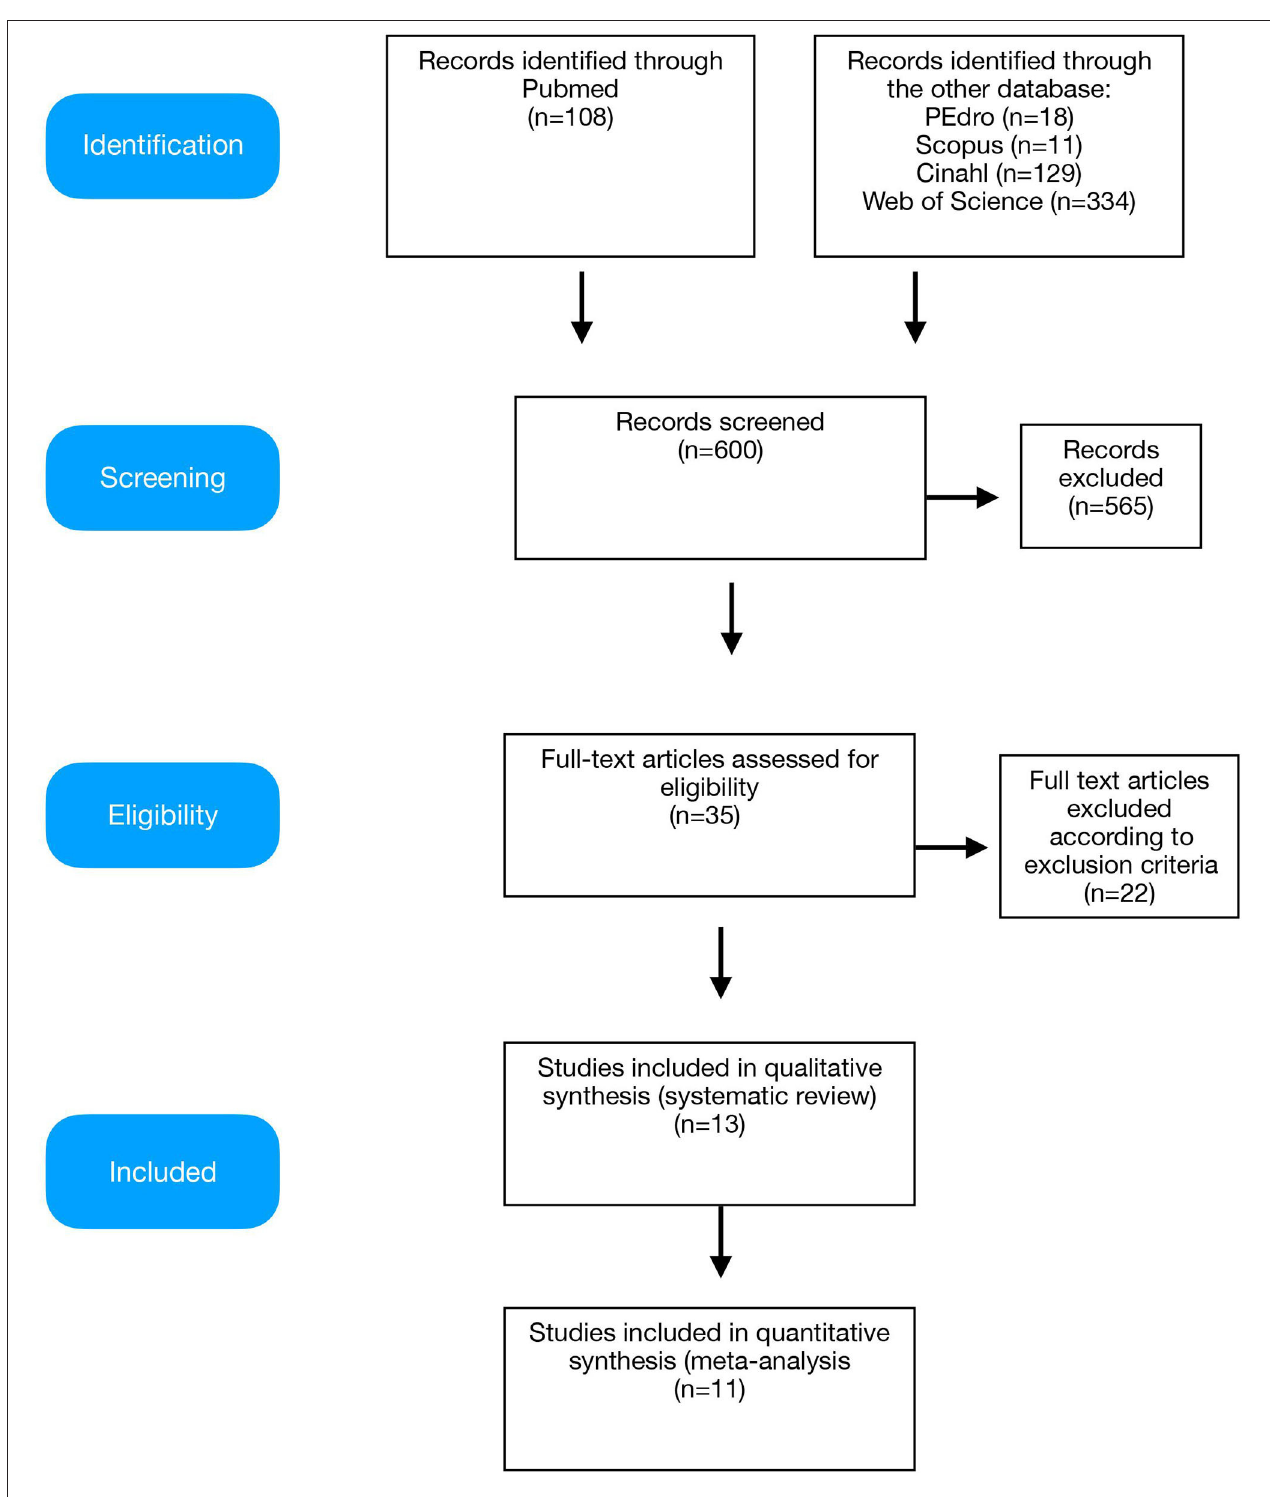
FIGURE 1 | Preferred Reporting Items for Systematic reviews and Meta-Analysis (PRISMA) diagram of the study.